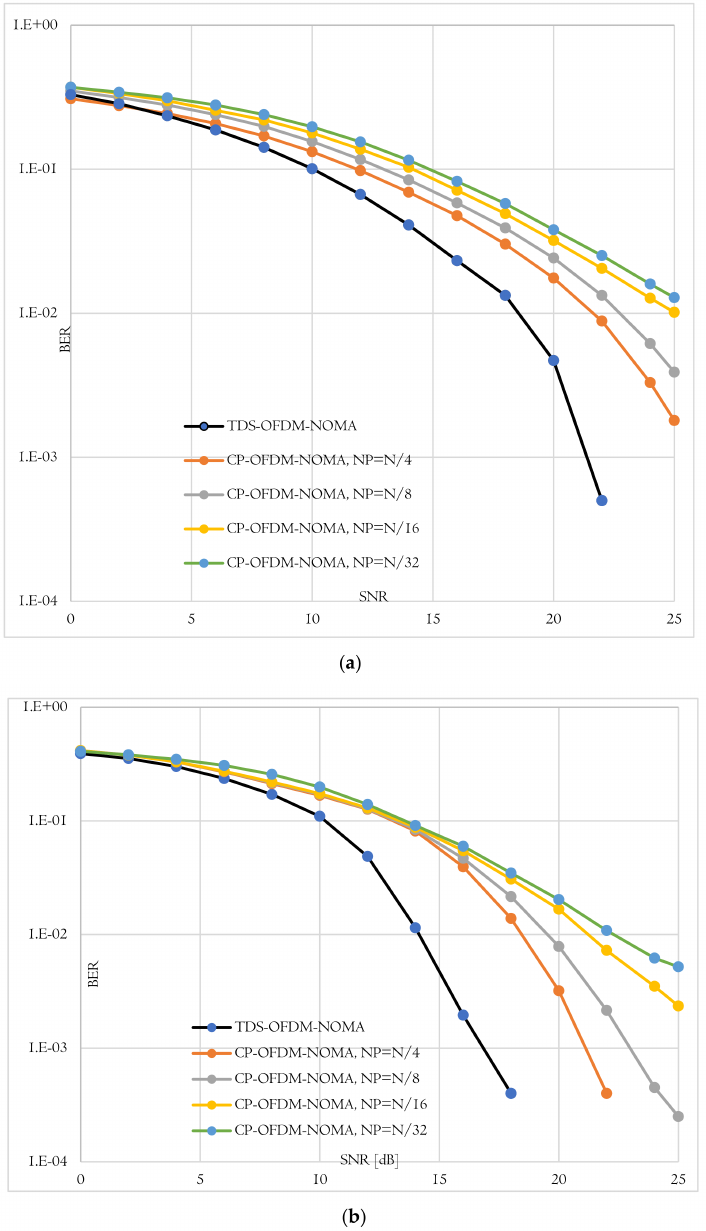
Figure 8. BER-total comparison of proposed TDS-OFDM-NOMA and convention CP-OFDM-NOMA; ( a ) Uncoded system and ( b ) Coded